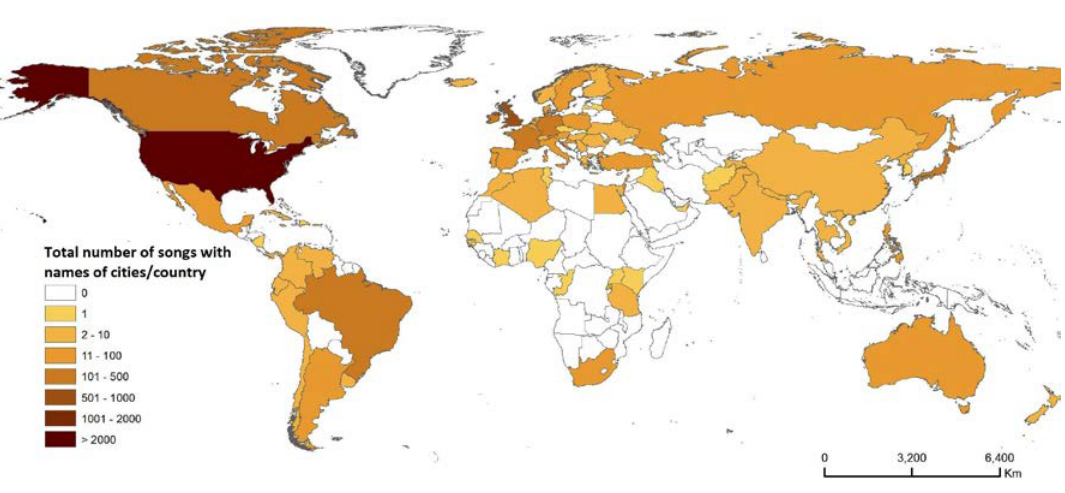
Figure 1: The map of the total number of songs named after cities per country Source: Ioan Sebastian JUCU (2016, p.